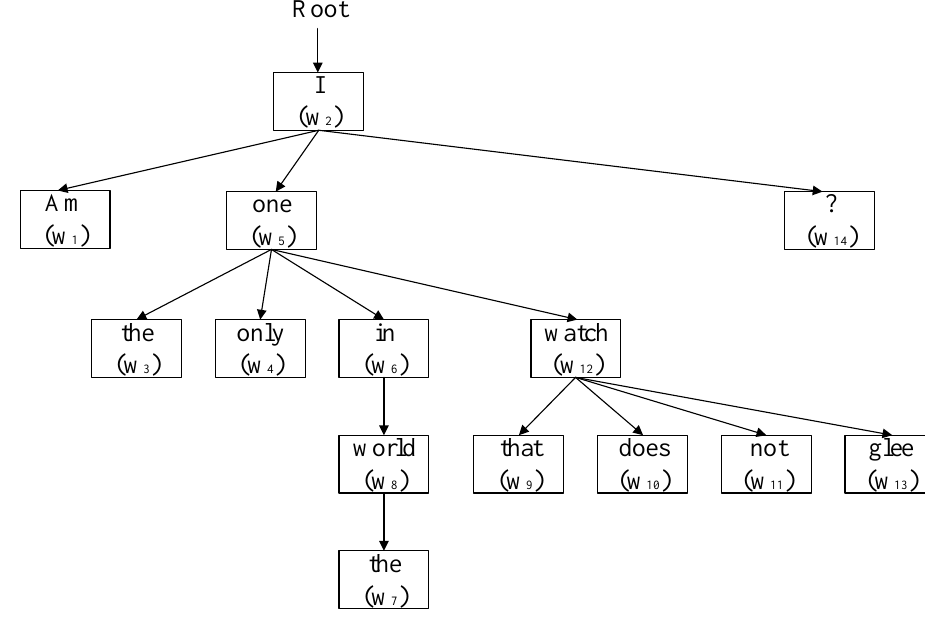
Figure 7. The syntactic tree structure of the example